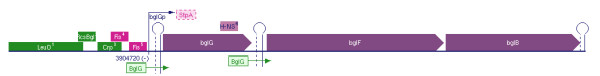
The transcription unit diagram for the E. coli bglGFB operon, showing regulation by a variety of transcription factors and attenuation by BglG. The diagram is not to scale; rather, the regulatory region has been expanded to show detail with the genes compacted. Sites shown in green activate and sites shown in magenta inhibit transcription. The location of the StpA binding site is unknown.